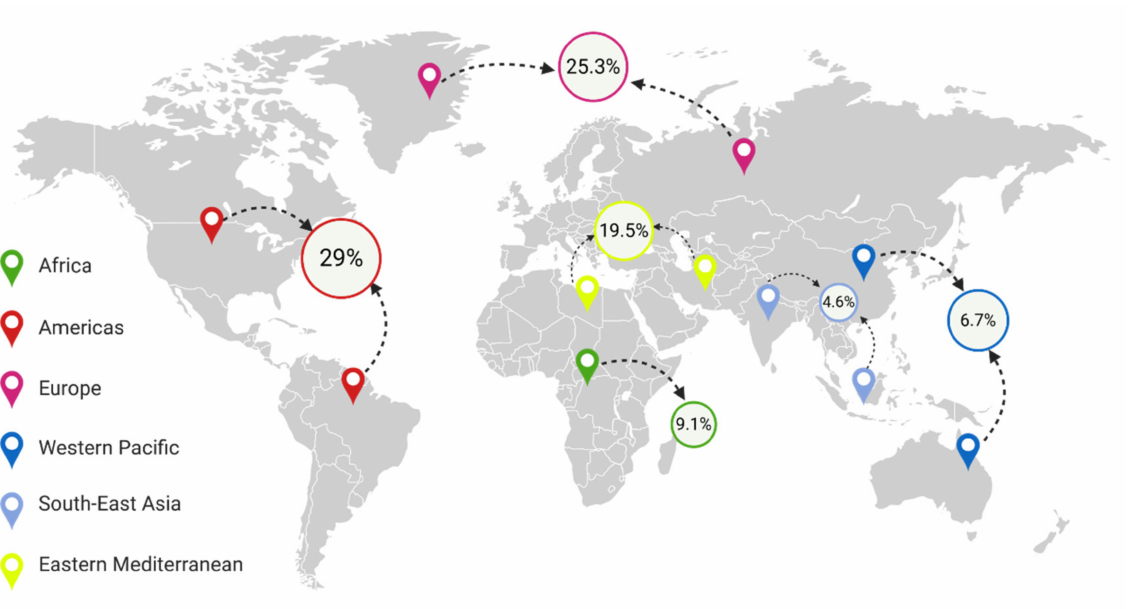
Figure 1. Percentage of people with obesity in different regions of the world